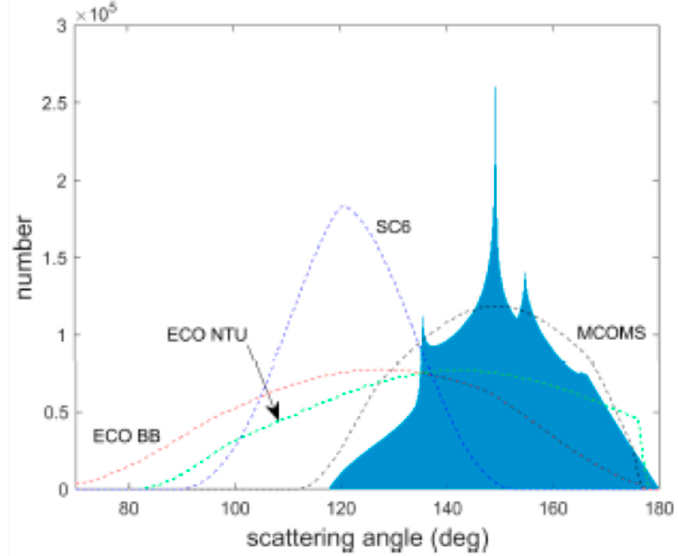
with this high-resolution figure: